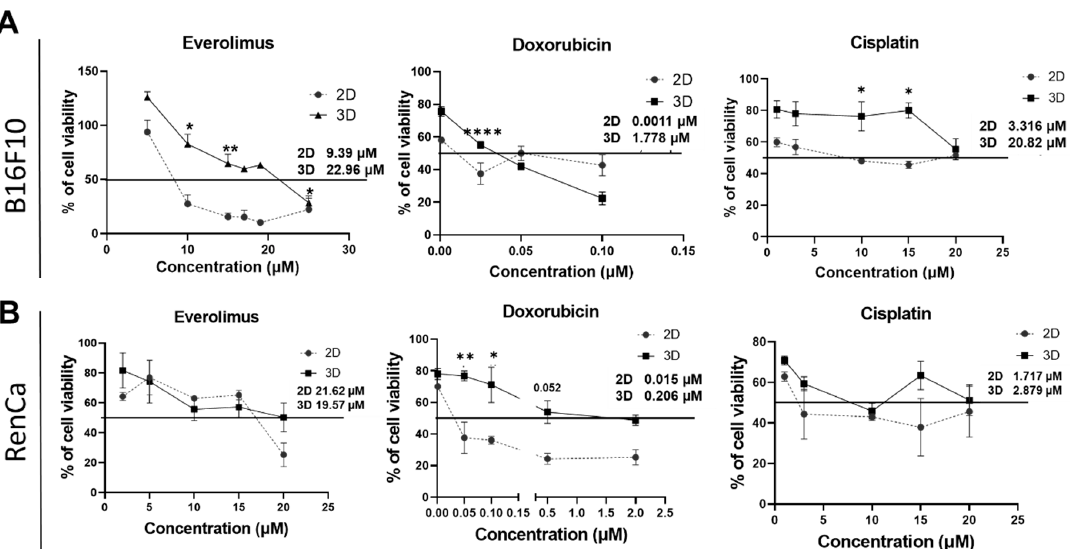
Figure 2. Sensitivity of cells in 2D and 3D culture. ( A )—sensitivity to everolimus, doxorubicin, and cisplatin of B16F10 cell line in 2D and 3D culture conditions as assessed by the use of the alamarBlue method. ( B )—sensitivity to everolimus, doxorubicin, and cisplatin of RenCa cell lines in 2D and 3D cultures assessed using alamarBlue method. Statistical analysis was performed by One-Way ANOVA/Tukey test or Kruskal–Wallis/Dunn’s test—* p < 0.05, ** p < 0.0021, **** p < 0.0001, N ≥ 3 (2D—control).